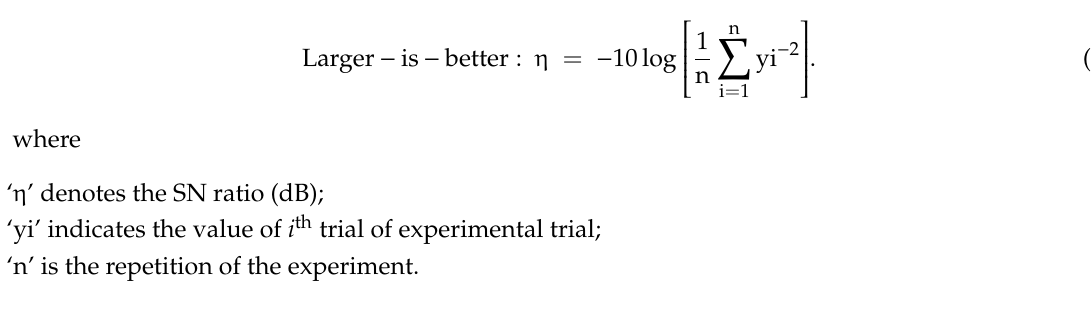
Table 5. Response observations and SN ratios of microhardness (MH) and surface roughness (SR).